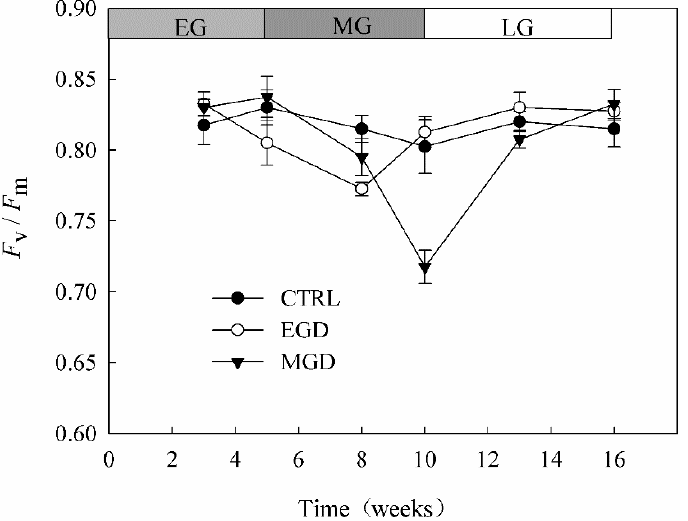
Figure 3. Dark-acclimated chlorophyll fluorescence ( F v /F m ) in the previous-year needles of Mongolian pine saplings by treatment. CTRL indicates the control. EGD and MGD indicate drought stress treatment in the early- (EG) and mid- (MG) growing seasons, respectively. EG, MG and LG refer to the early- (weeks 1–5), mid- (weeks 6–10) and late- (weeks 11–16) growing season, respectively. Time indicates weeks from the beginning of the experiment. Bars indicate standard error ( n = 4).